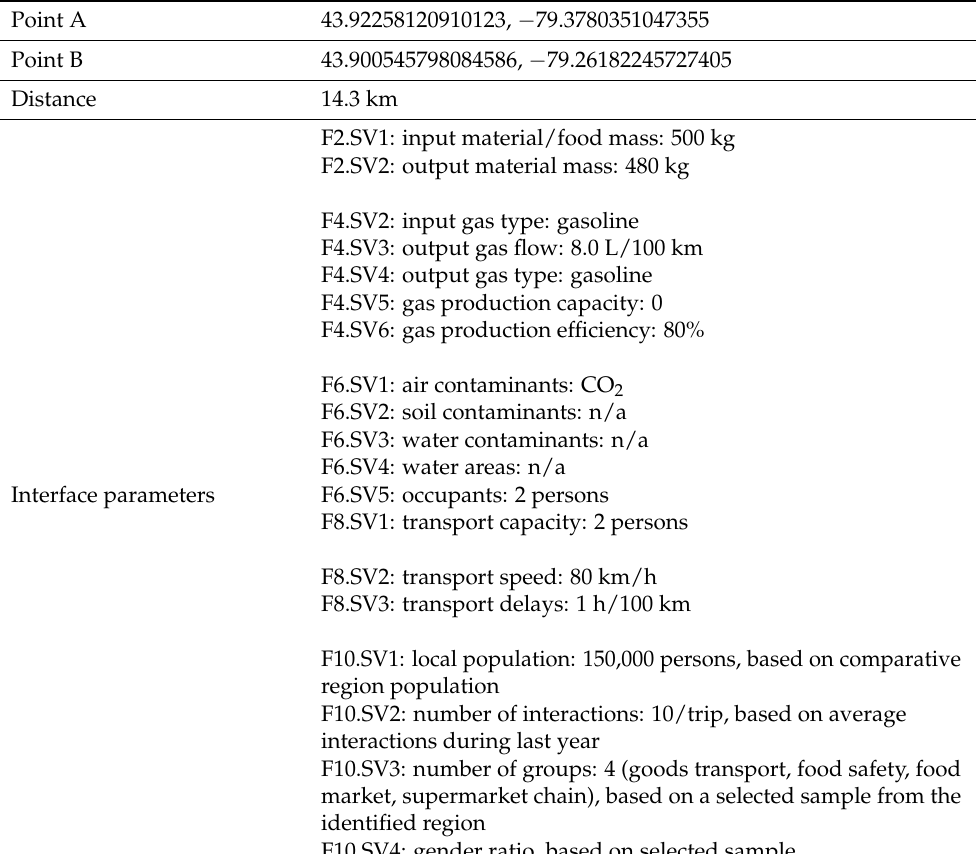
Table 5. Scenario details of transportation of food via vehicle from point A to point